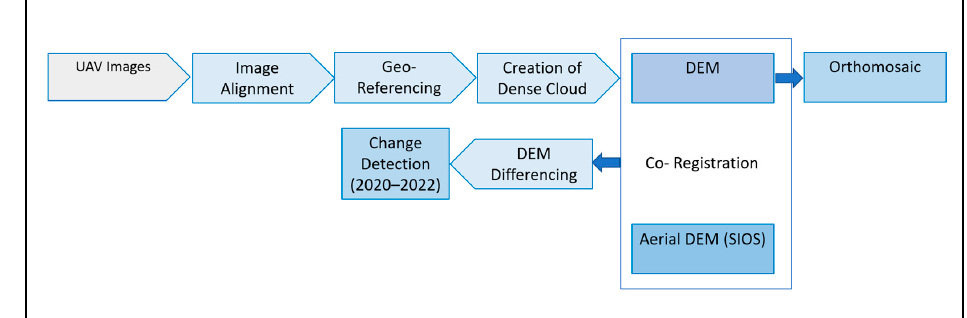
Figure 3. Flowchart of the data processing and change detection applied in this study.